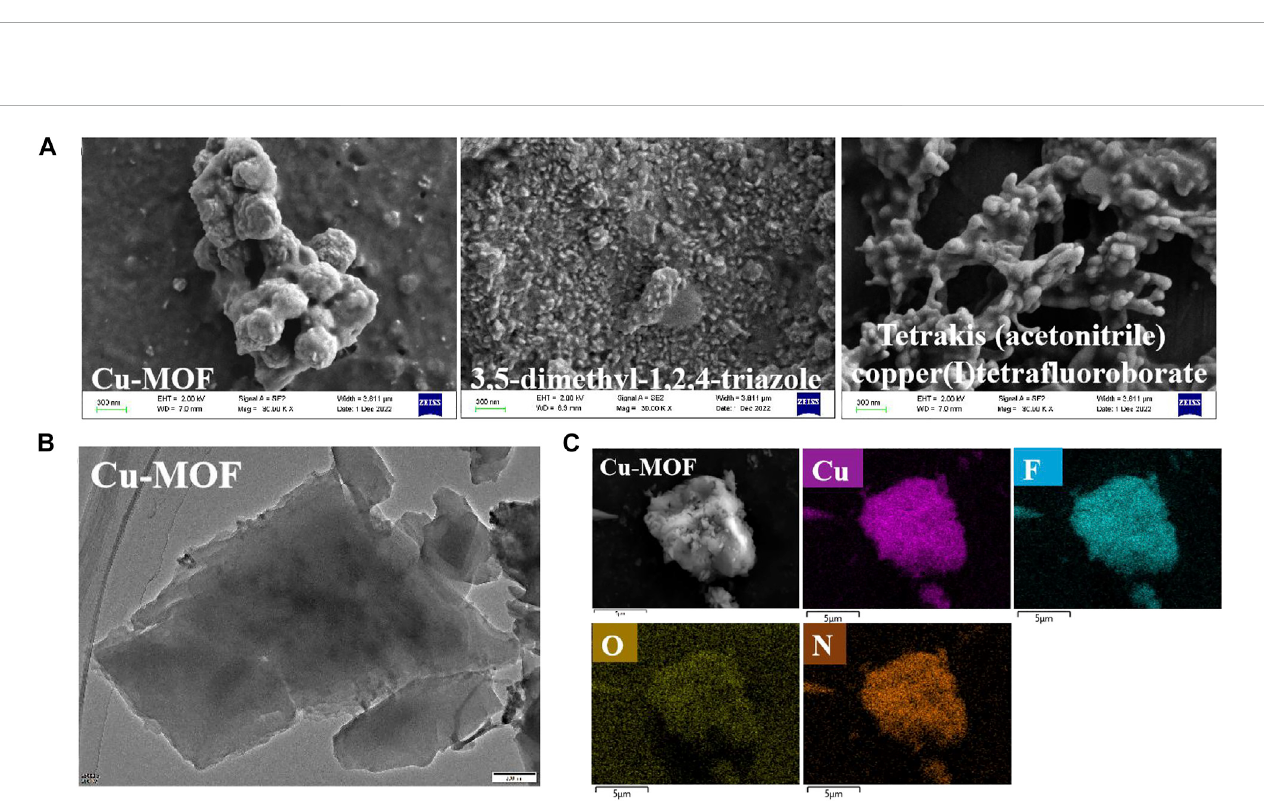
FIGURE 1 (A) XRD patterns, (B) N (C) pore size distribution of different powder samples of Cu-MOF, 3,5-dimethyl-1,2,4- 2 adsorption-desorption isotherms, and triazole and tetrakis (acetonitrile) copper (I) tetra fl uoroborate powder, respectively.